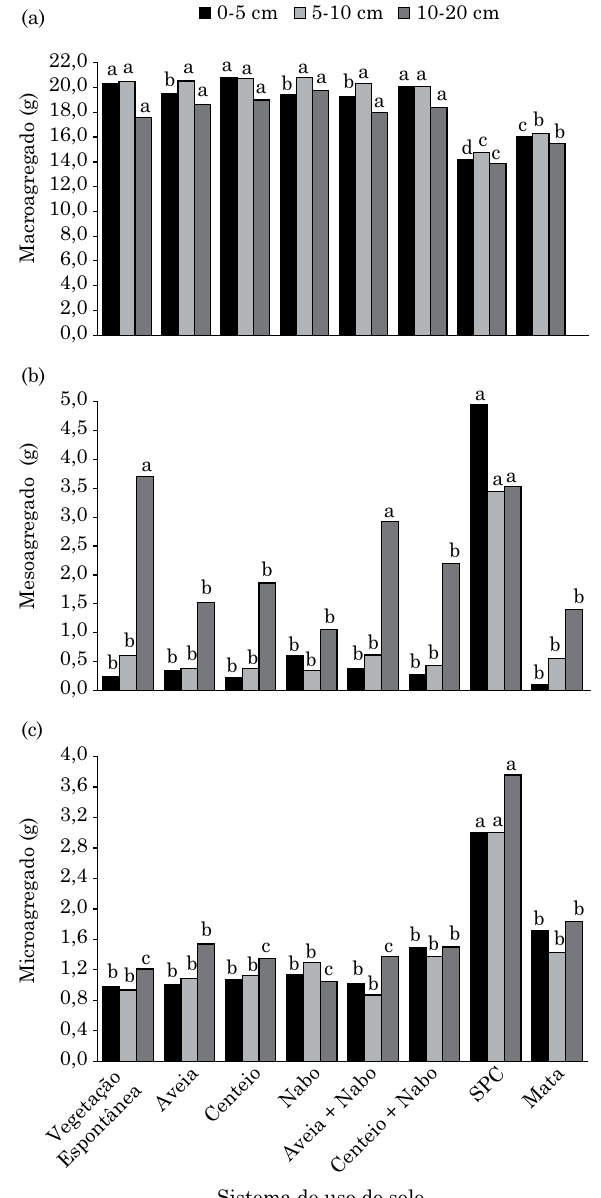
Figura 1. Distribuição da massa de macroagregados (Ø≥2,0 mm), mesoagregados (2,0>Ø≥0,25 mm) e microagregados (Ø<0,25 mm) estáveis em água em sistemas de uso do solo com cultivo de cebola nas profundidades de 0-5, 5-0 e 10-20 cm. Médias de cinco repetições seguidas de mesma letra, entre sistemas de uso do solo para cada profundidade, não diferem entre si pelo teste de Skott-knott